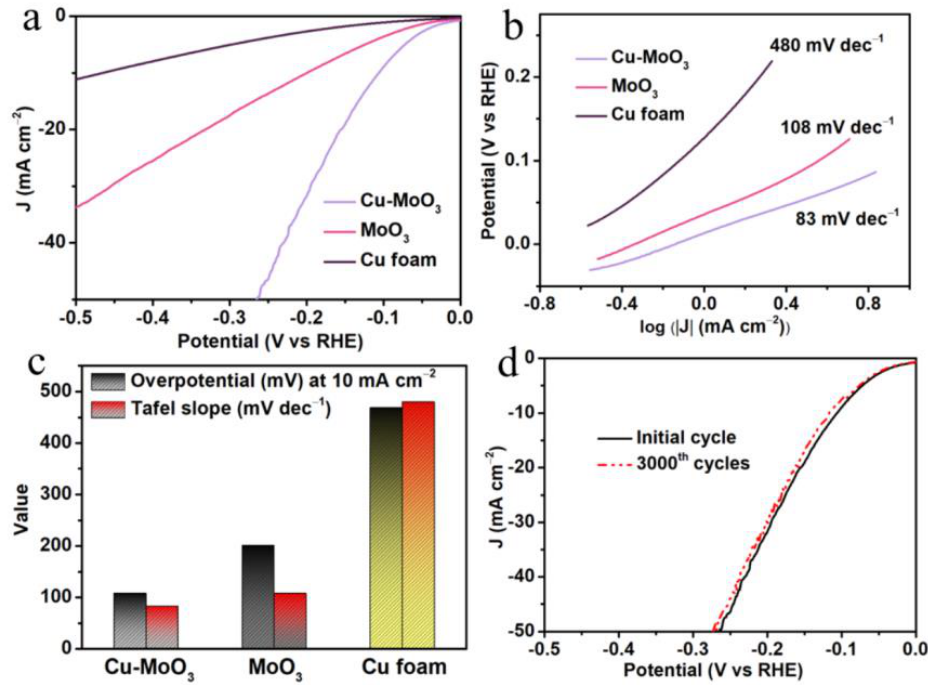
Figure 5. ( a ) The polarization curve, ( b ) Tafel slopes, ( c ) comparison of performance and ( d ) stability of as-prepared samples in 1 M KOH solution.